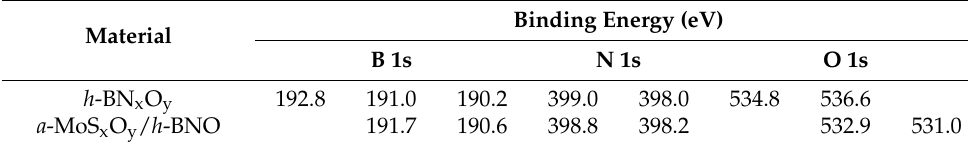
Table 1. Binding energy values of B 1s, N 1s, and O 1s peaks of h -BN x O y and a -MoS x O y / h -BN x O y materials in accordance with the deconvolution of XPS spectra, as shown in Figure 2d–i.